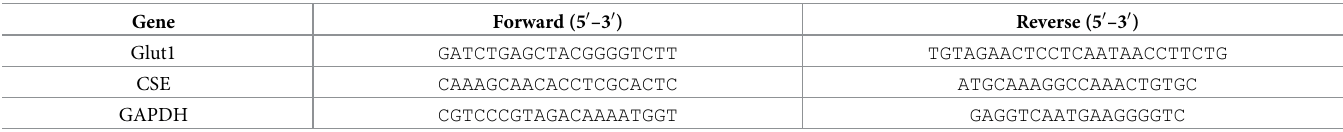
Table 1. PCR primer sequences.